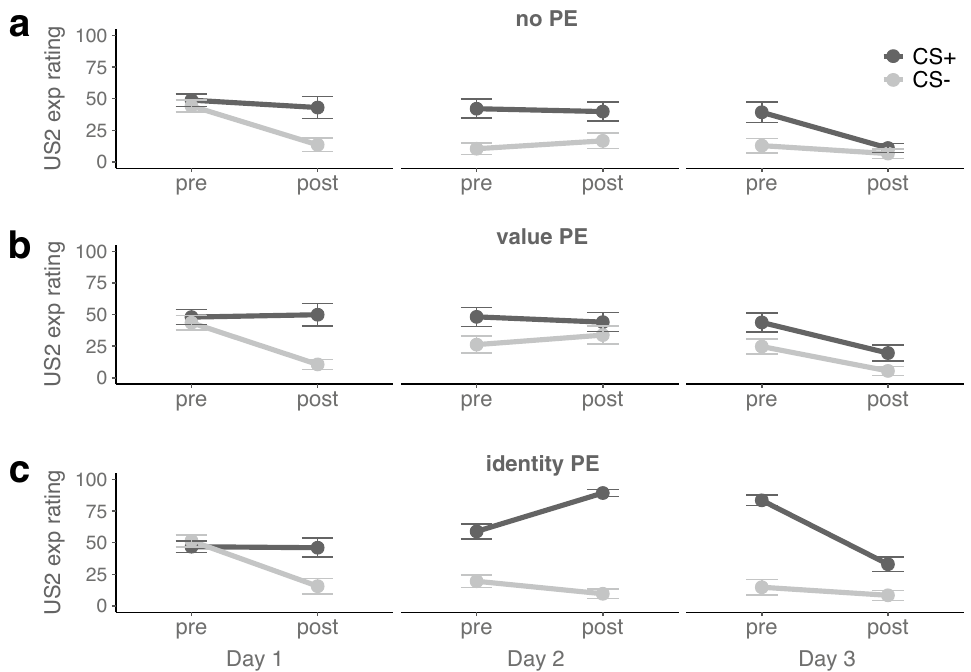
Figure 3. Pre- and post-session expectancy to receive the US2 for CS+ and CS− in ( a ) the no-PE control group, ( b ) the value-PE group for which the US1 was omitted during memory reactivation on day 2, and ( c ) the identity-PE group for which the CS+ was paired with the US2 during memory reactivation on day 2. Error bars depict standard error of the